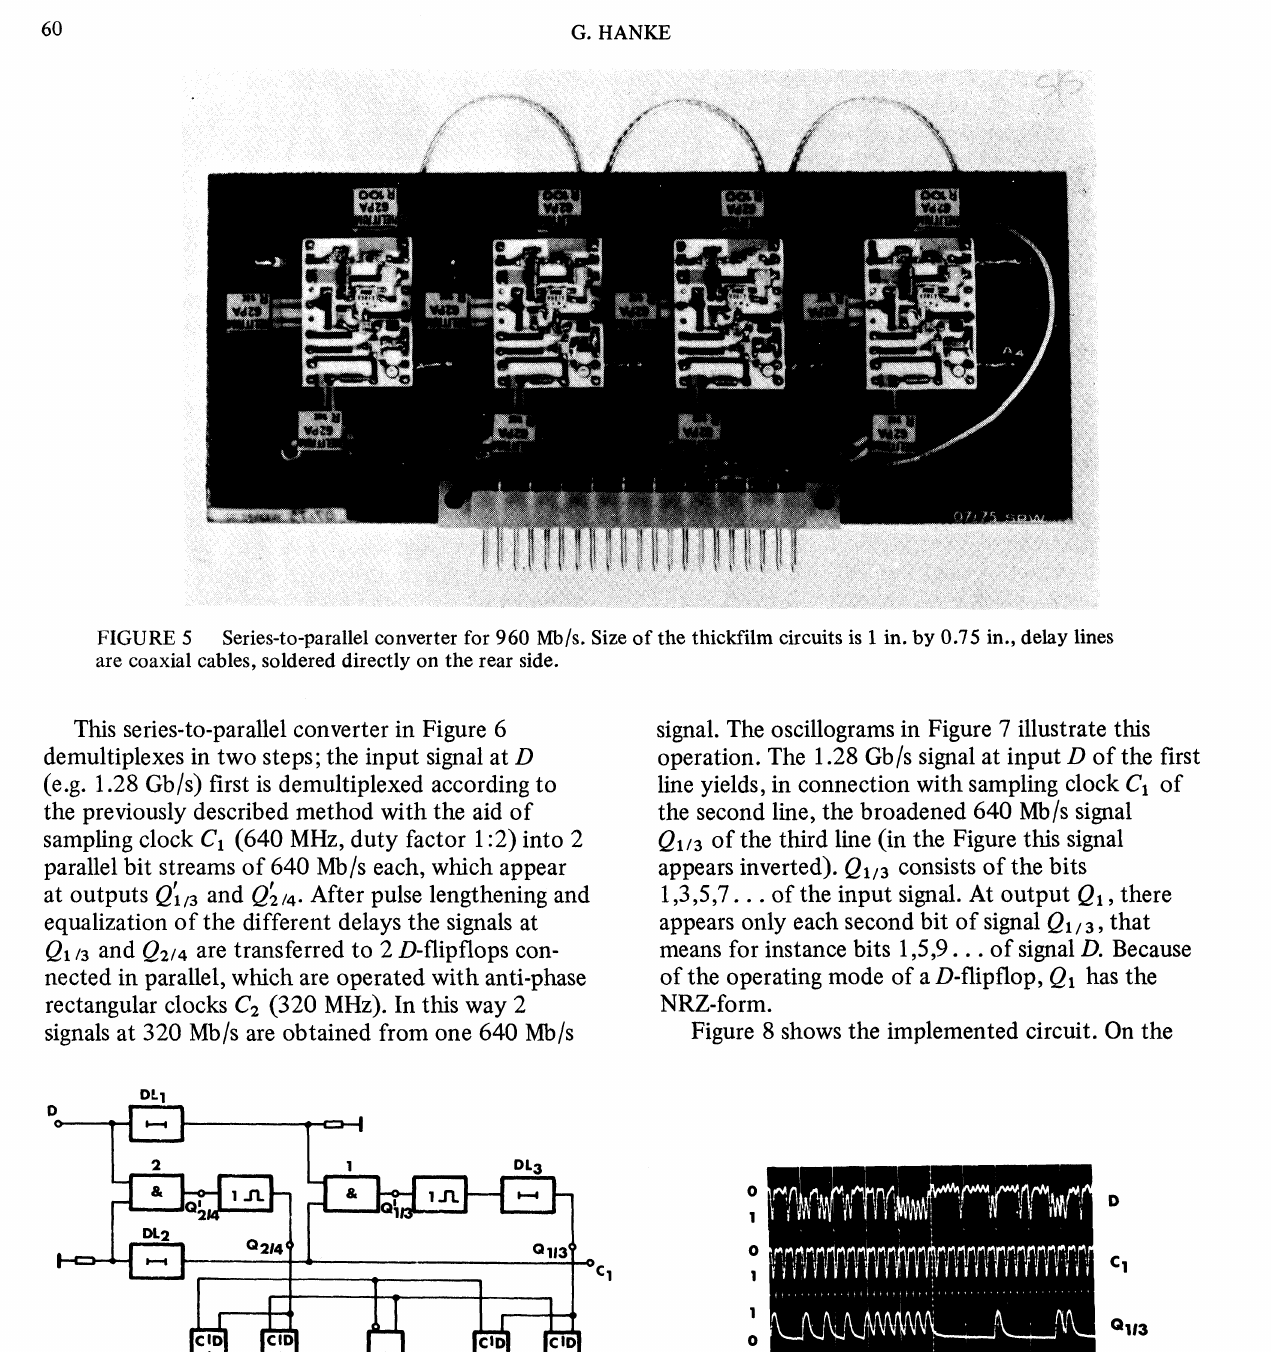
FIGURE 6 Series-to-parallel converter for 1.28 Gb/s. Oscillograms of Figure 6 circuit. Data signal D and clock C produce output Q/3. The second demultiplex- ing yields QI. Horiz.: 5 ns/unit, vert.: 1